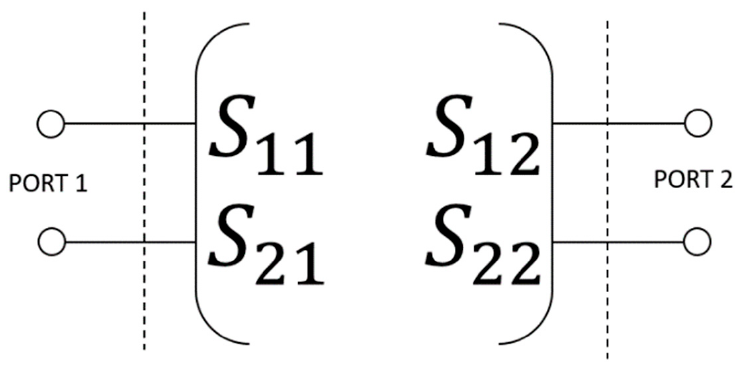
Figure 1. Modeling of the proposed circuit geometry assuming lossless transmission line sections.